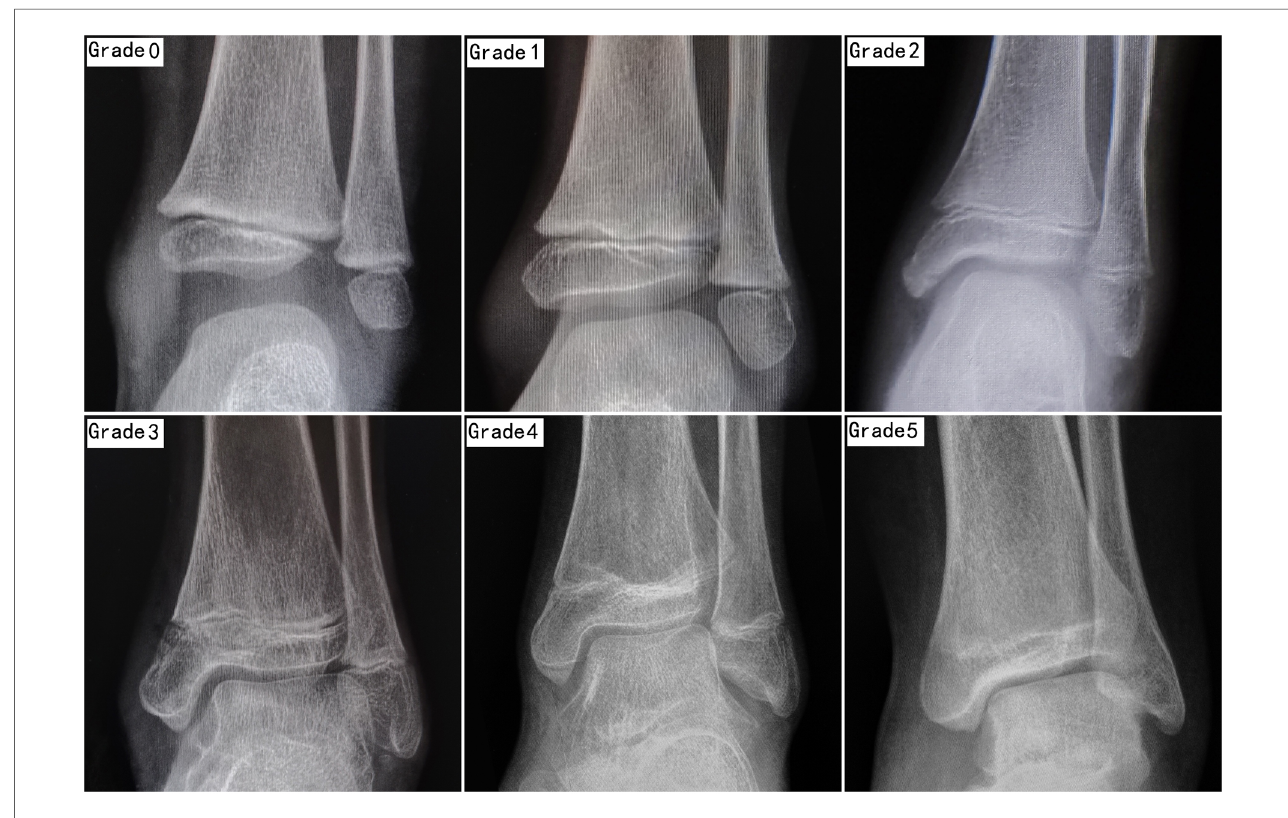
FIGURE 1 X-ray of grades of tibial epiphysis